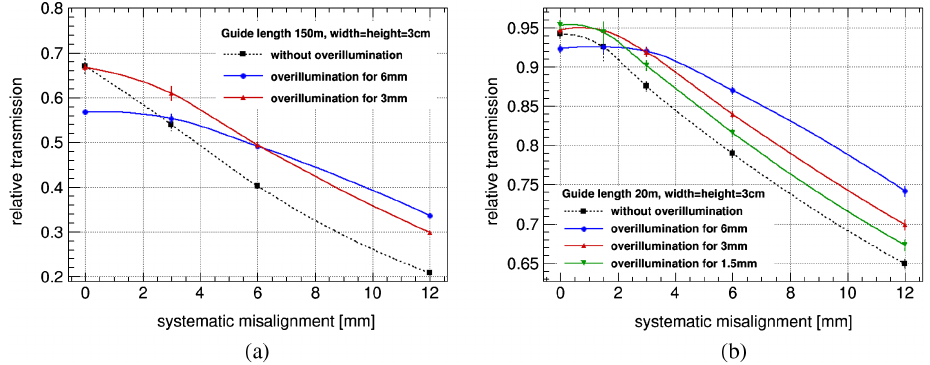
FIG. 4. Relative transmission with respect to perfectly aligned guide, with different amounts of systematic vertical misalignment and overillumination for a certain expected misalignment, 150 m guide (a) and 20 m guide (b) with 1 m long segments. Systematic plus random misalignment using the mean of five random misalignment sets. Note that the y axes are suppressed and have different scales in each